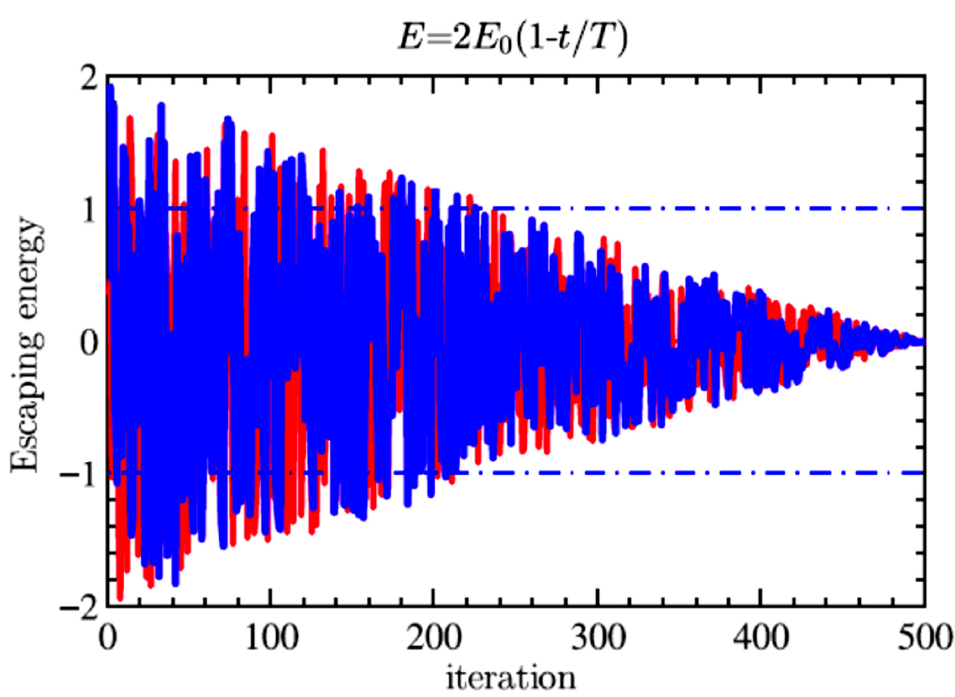
Figure 2. Escaping energy trend for two runs [50]. Figure 2.